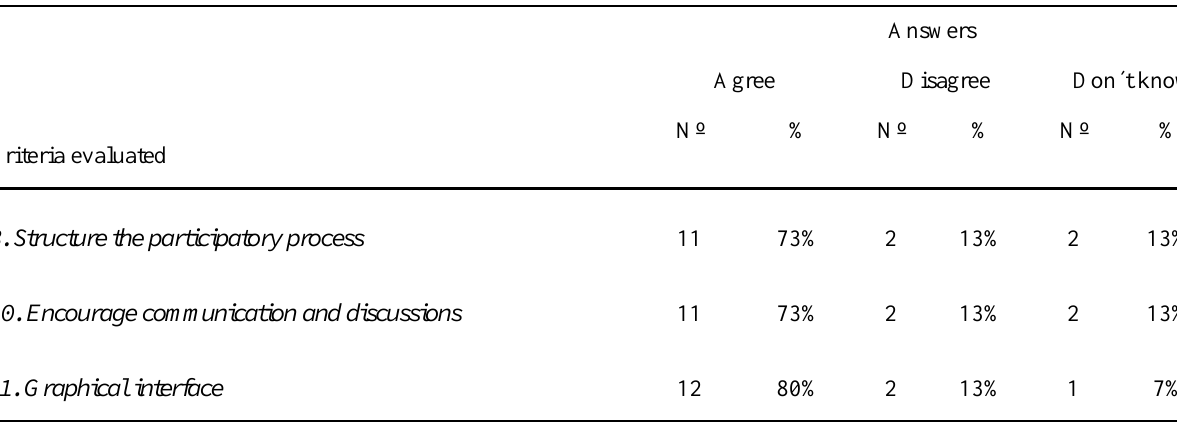
Table 6 . Capabilities of BNs as participatory